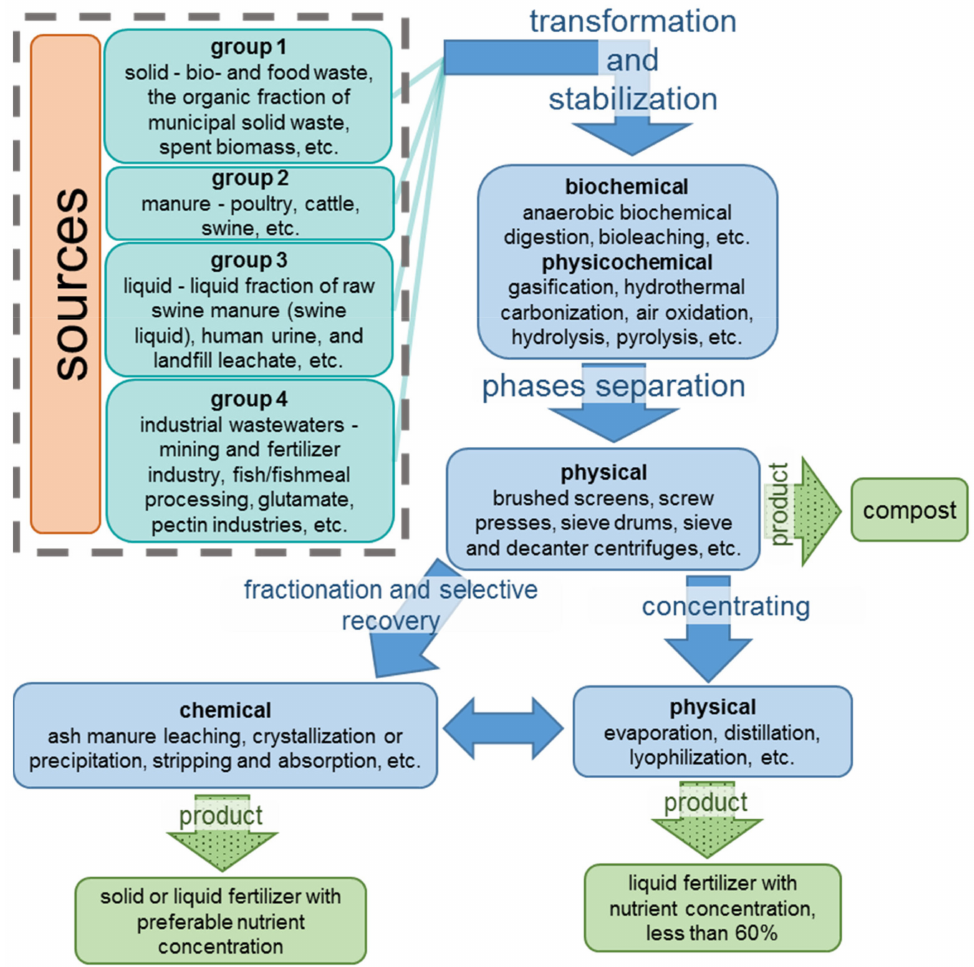
Figure 1. An overview of residual streams and their processing